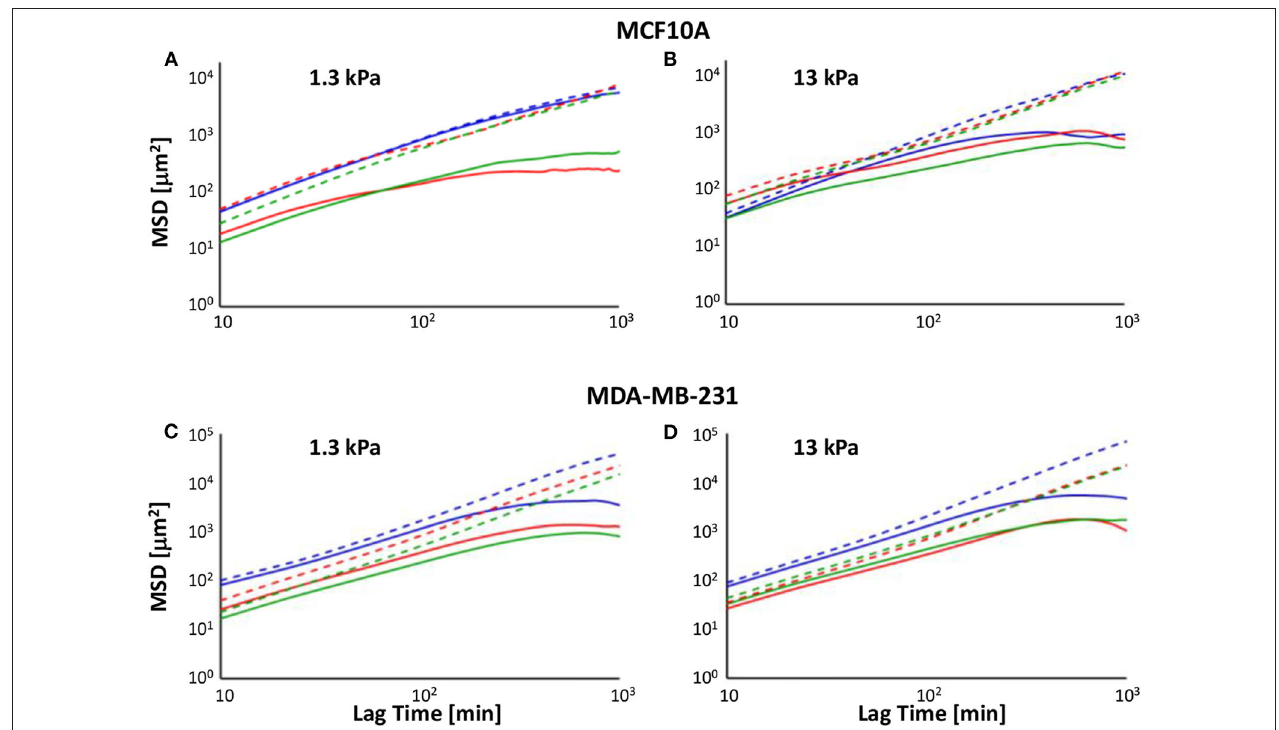
FIGURE 3 | Log-log plot of MSDs along x ′ - (solid line) and y ′ - (dotted lines) directions of MCF10A (A,B) and MDA-MB-231 cells’ (C,D) trajectories on soft (A–C) and stiff (B–D) PAAm substrates, in control condition (blue) and 72h after irradiation with doses of 2Gy (red) and 10Gy